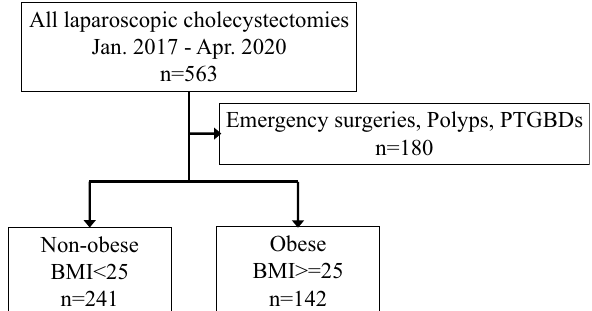
Figure 1. Flow chart of this study. BMI, body mass index; PTGBD, percutaneous transhepatic gallbladder drainage.